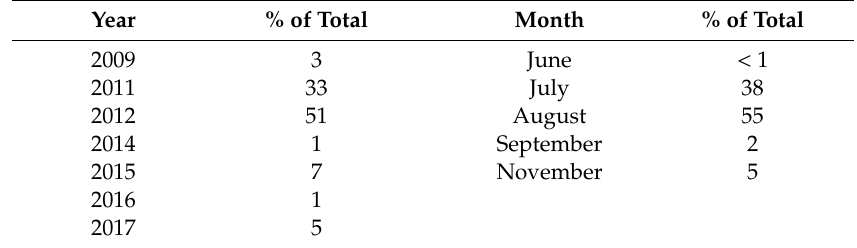
Table 1. Year and month of Google Street View imagery availability for the street segments included in the virtual survey.